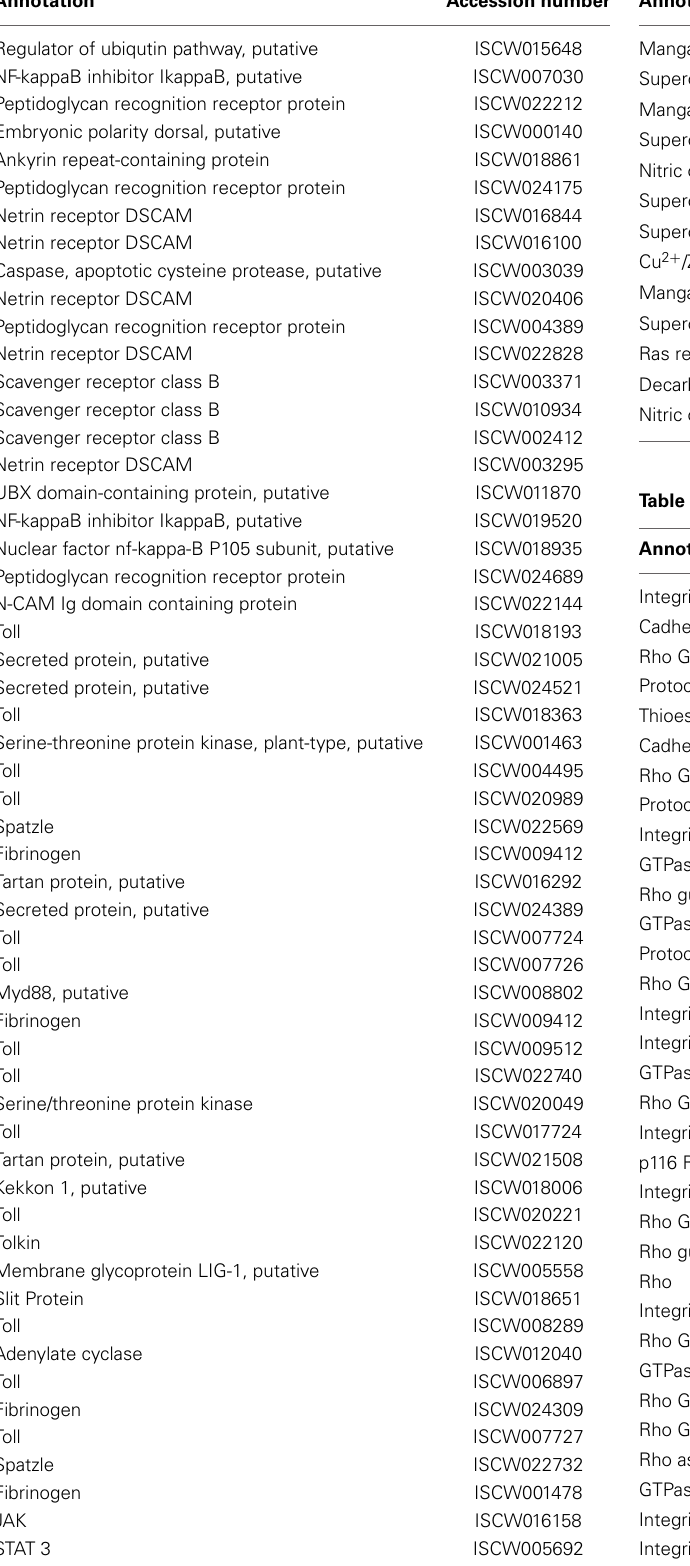
Table 6 | Non-self recognition (Toll, IMD, and JAK-STAT pathways). Table 7 | Free radical defense.